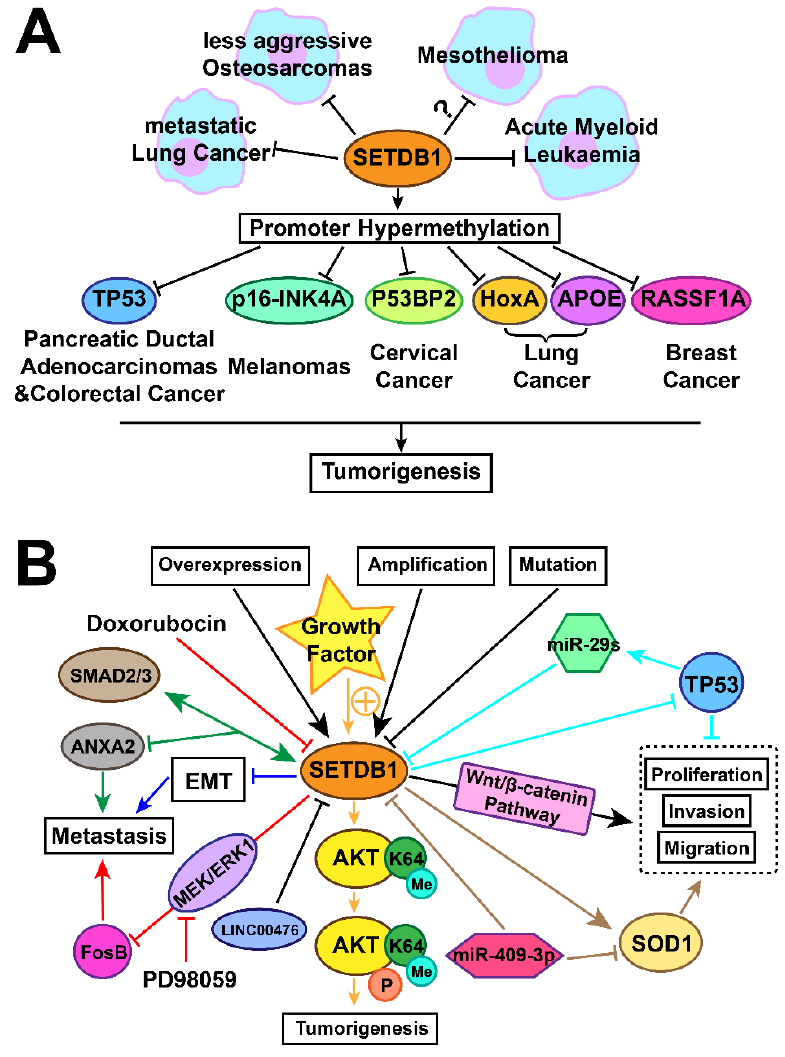
Figure 2. Functions and regulatory mechanisms of SETDB1 in different cancers. ( A ) The expression of SETDB1 differs in various cancers, indicating that SETDB1 may act as oncoprotein or tumour suppressor. ( B ) In lung cancer, SETDB1 was downregulated by self-mutation, miR- 29s /SETDB1/ TP53 circuitry, LINC00476 , and miR-409-3p , while SETDB1 was upregulated under overexpression/amplification or induced by growth factor. SETDB1 facilitates the development of lung cancer by positively regulating SOD1, AKT methylation and the WNT/ β -catenin pathway while negatively regulating the expression of FosB. Additionally, SETDB1 connects with SMAD2/3 and downregulates EMT biomarkers to repress the development of lung